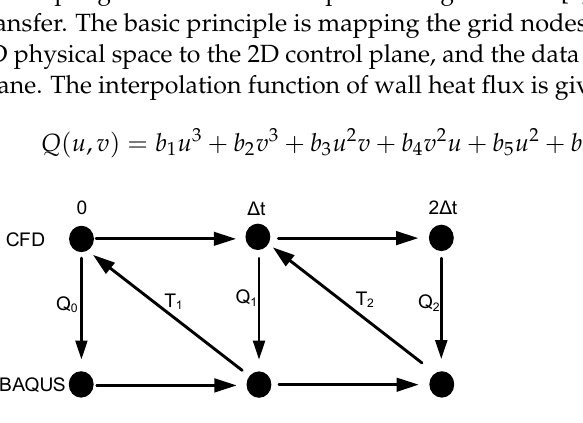
Figure 1. Transient coupled method.